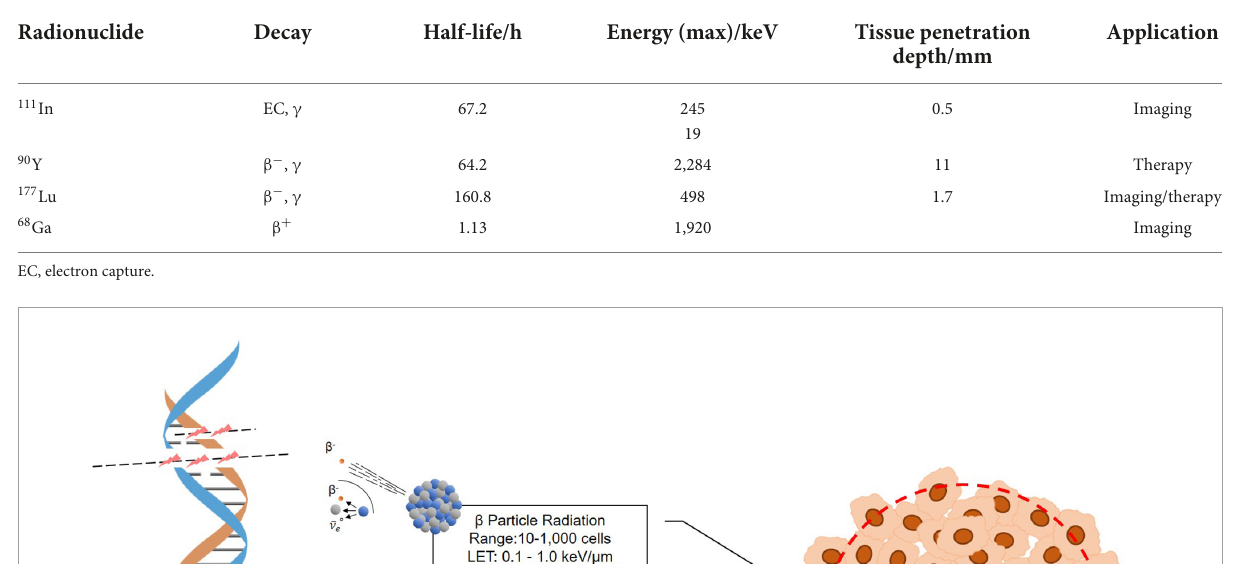
TABLE 1 Physical properties of selected radioisotopes used in PRRT to treat NETs.